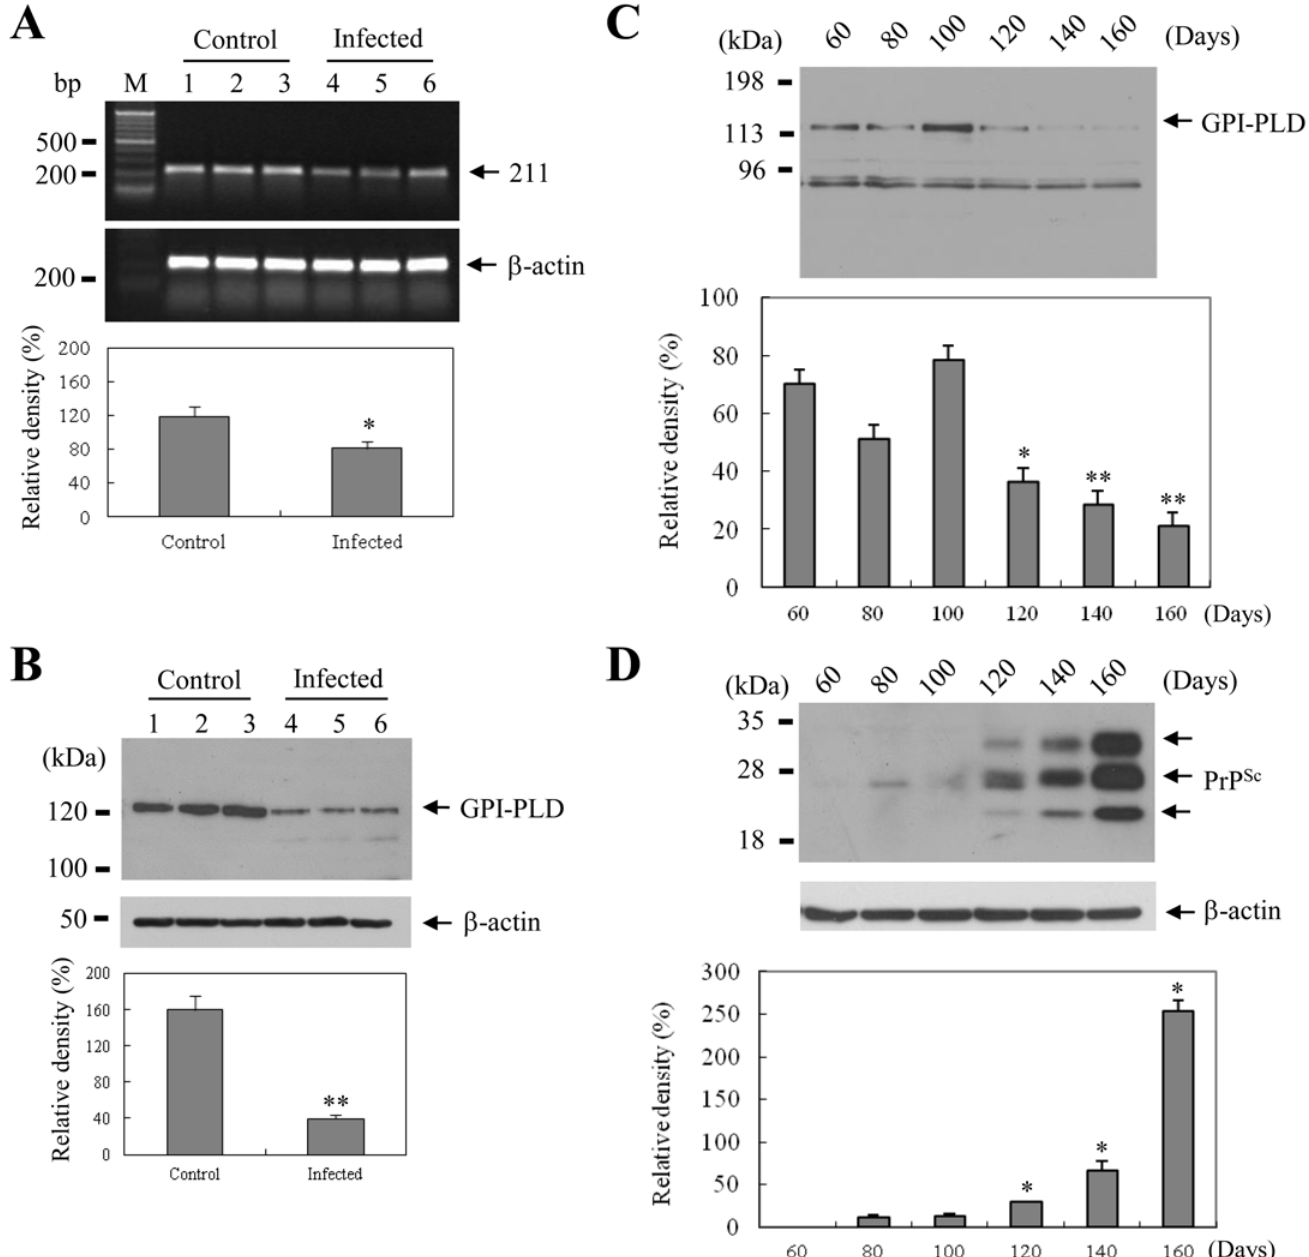
Fig 1. GPI-PLD is down-regulated in the scrapie-infected brains. ( A ) RT-PCR analysis of GPI-PLD expression levels using total RNA samples extracted from the whole brains of mice injected with either ME7 or normal brain homogenates at 160 dpi. The GPI-PLD mRNA levels were quantified using a densitometer analysis. Each value represents the mean ± SD of three samples. * Significance P < 0.05 compared with control levels. Actin was used as the control. ( B ) Western blot analysis of GPI-PLD protein levels in whole brain at 150 dpi from mice injected with either ME7 or normal brain homogenates. Total brain lysates of control and scrapie-infected mice were prepared as described in the Materials and Methods section and analyzed by western blotting with the GPI-PLD antibody. Each value represents the mean ± SD of three samples. ** Significance P < 0.01 compared with control levels. Each experiment was repeated at least three times, and similar results were obtained in each experiment. β -actin was detected by anti- β -actin antibody and it served as the control. ( C-D ), GPI-PLD begins to be reduced at the time PrP Sc is detected. Total lysates, which were prepared as described in the Materials and Methods section, were analyzed by Western blotting with the anti-GPI-PLD (C) and anti-PrP 10E4 antibodies; the latter experiment is done following PK treatment (D). Each experiment was repeated at least three times, and similar results were obtained in each experiment. β -actin was detected by anti- β -actin antibody and was used as the control. * Significance p < 0.05 compared to control 60 days after scrapie infection; ** Significance p < 0.01 compared to control 140 and 160 days after scrapie infection.